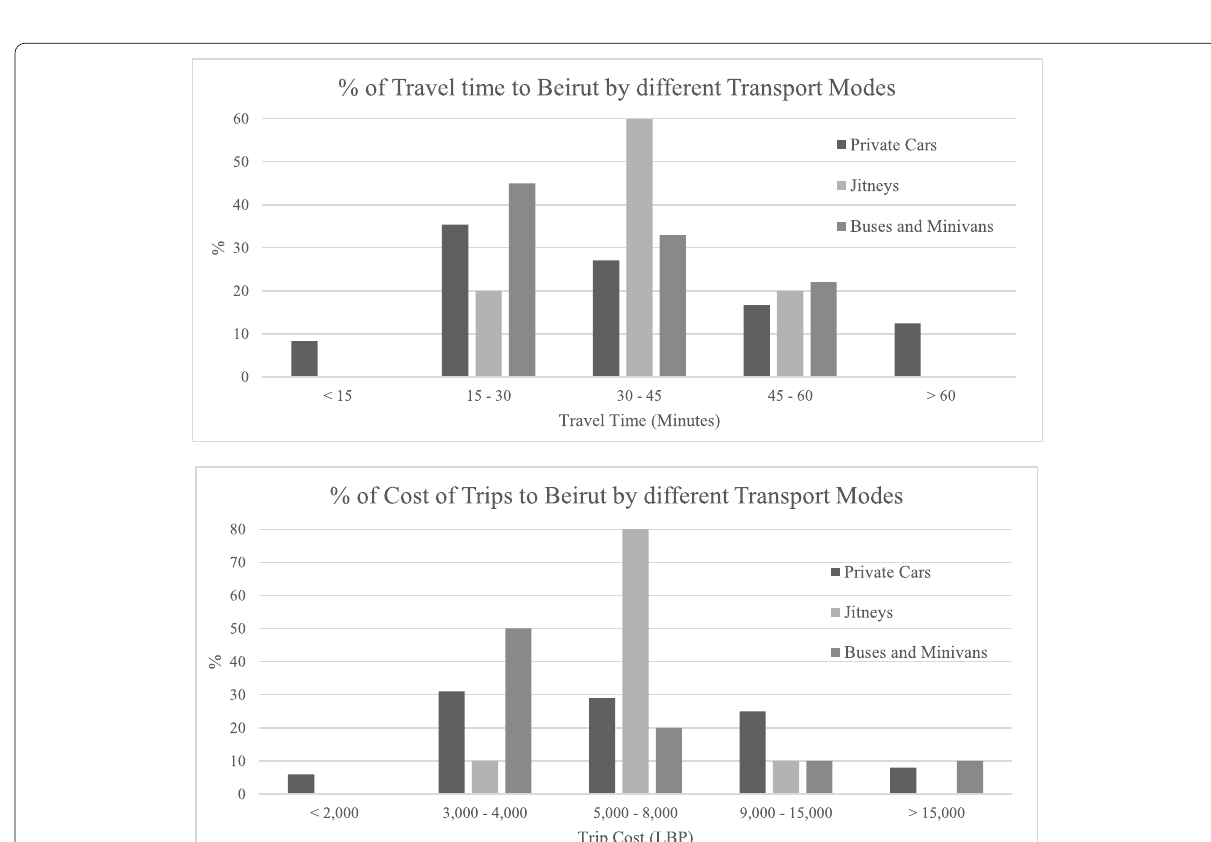
Fig. 7 Percentages of Travel times and Costs for trips to Beirut by different Transport